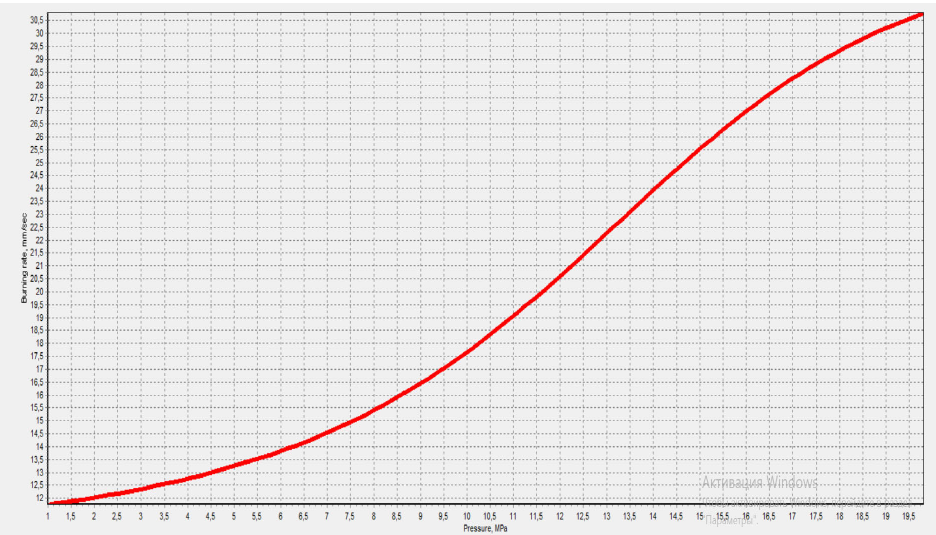
Figure 9. The graphs of the dependence of the burning rate on pressure, corresponding to the results of calculation of ANN MCM for virtual experiment (right side of the Table 3, direct task for a virtually modified propellant composition.